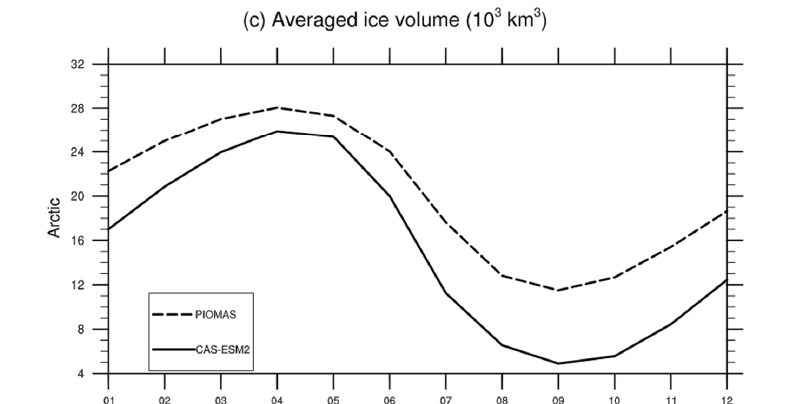
Figure 9. Average ice thickness during freezing season from ( a ) CS2SMOS observations during 2010– 2019 and ( b ) CAS-ESM 2.0 for ensemble mean of 1979–2014 historical simulation in the Northern Hemisphere, and ( c ) simulated average ice volume in the Arctic during 1979–2014.